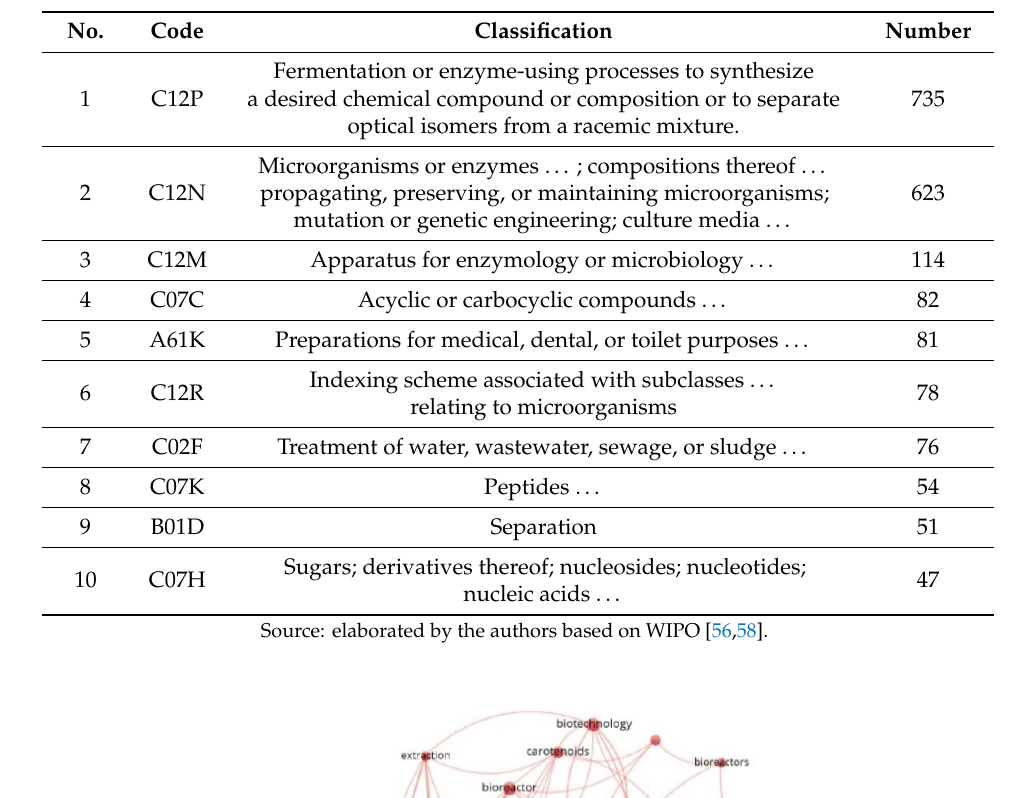
Table 1. Patent applications by technological field (2010–2019).